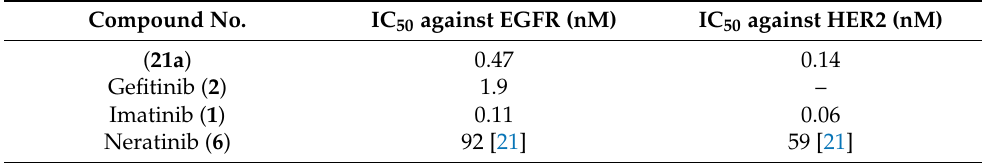
Table 2. In vitro inhibitory activity of compound 21a against EGFR and HER2 enzymes. Compound No.